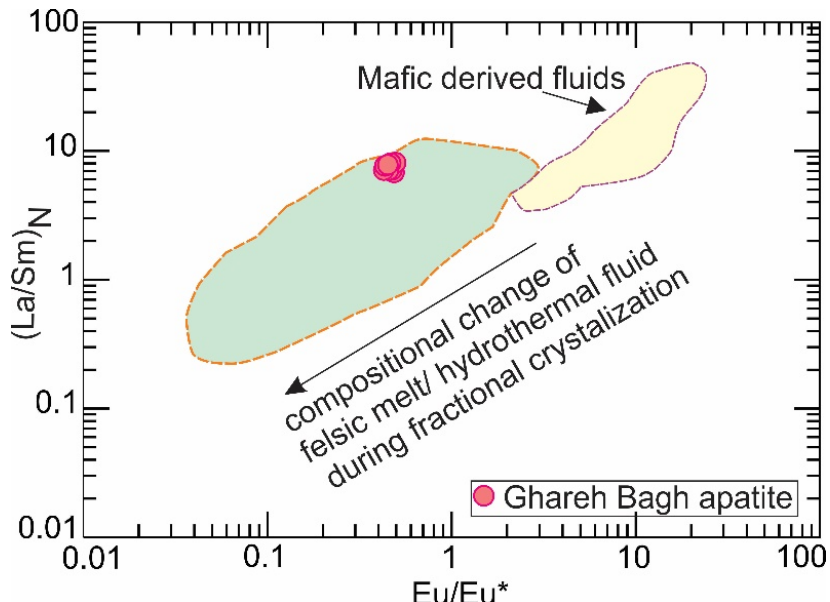
Figure 7. Biplot of La/Sm vs. Eu/Eu*. Fields of hydrothermal derived felsic and mafic melt from Adlakha et al. [52]. The Ghareh Bagh’s apatite are plotted in a hydrothermal-derived felsic magma.